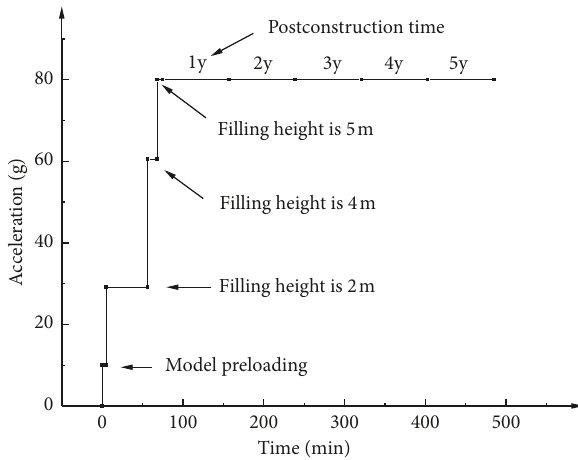
Figure 6: The running time curve.